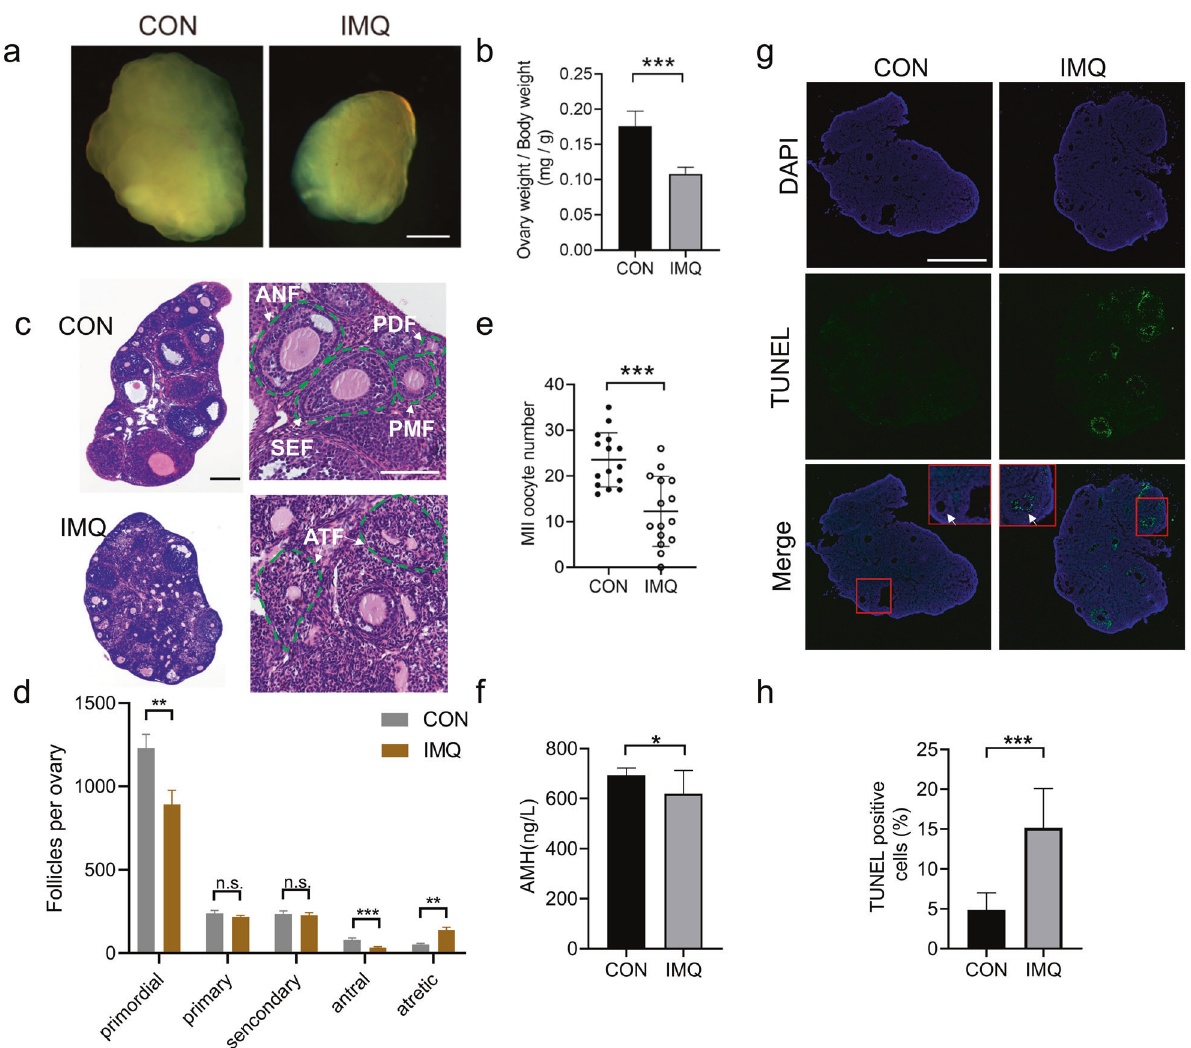
Fig. 2 Effects of psoriasis-like symptoms on ovarian reserve. a Light microscopy images of ovarian tissues. b The ratio of ovarian weight to bodyweight from IMQ and CON groups. c Ovarian sections from IMQ and CON group ( n = 4 for each group). PDF primordial follicles, PMF primary follicles, SEF secondary follicles, ANF antral follicles, ATF atretic follicles. d Follicle counts in ovarian sections from IMQ and CON groups. e Numbers of MII oocytes obtained from per mouse after superovulation. f The serum levels of AMH are measured by ELISA. n = 10 for each group. Apoptosis of cells was stained with FITC staining, shown as green fl uorescence. The nucleus shown as blue fl uorescence with DAPI. g Images of ovarian cells after TUNEL staining. White arrow indicates granulosa cells. Apoptotic granulosa cells show a TUNEL-positive signal. h Quantitative analysis of TUNEL-positive cells in ovarian tissues. n = 6 for each group. Scale bar: 200 µm. Data present as mean ± SD. ** P < 0.01, *** P < 0.001, ns none signi fi